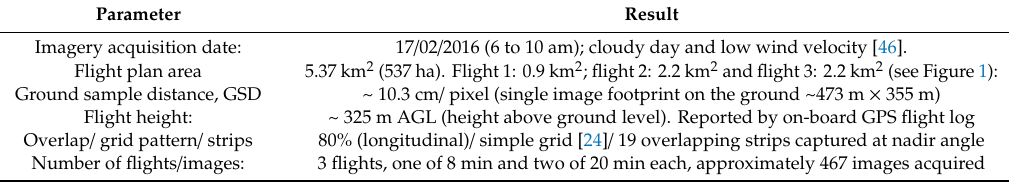
Table 1. Summary of technical parameters for UAV-based imaging surveys on the study area.